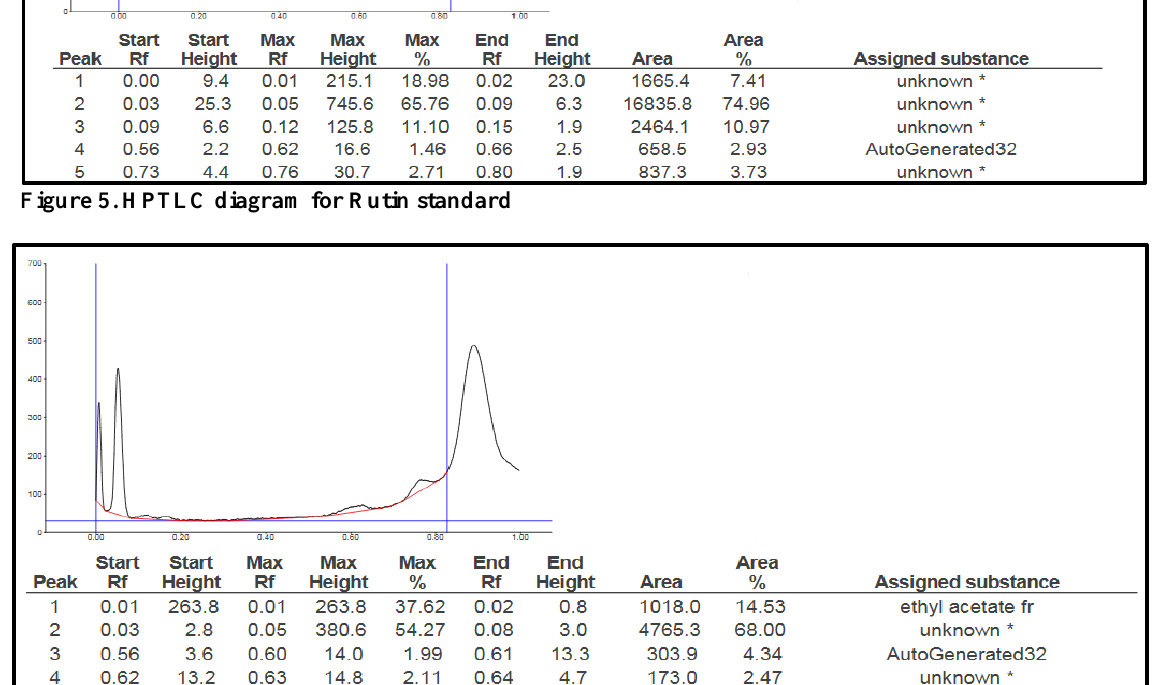
Figure6. HPTLC diagram for isolated